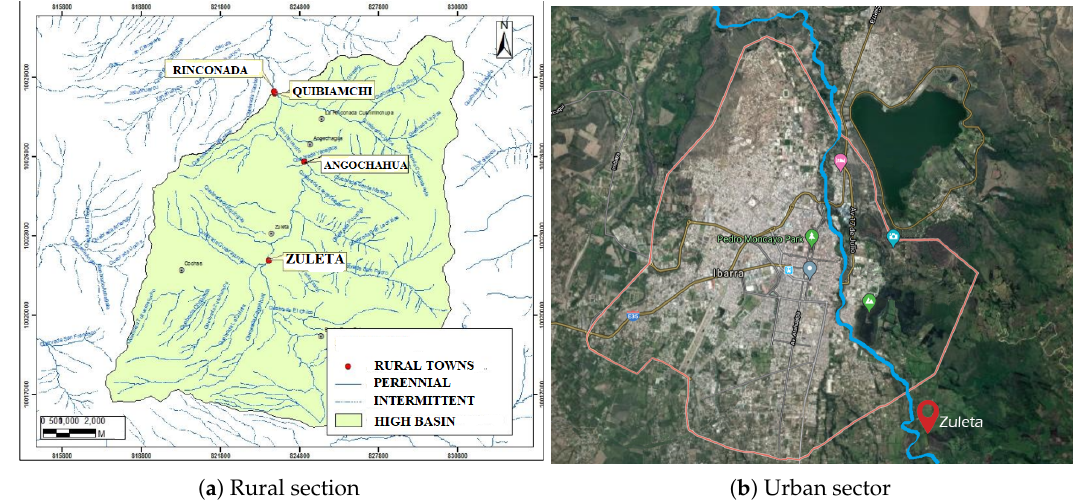
Figure 1. Geographical description of Tahuando river. Zoomed view of the river route highlighting remarkable surrounding communities in Ibarra city’s urban sector ( right ), and a widespread view regarding the rural section of Imbabura province ( left